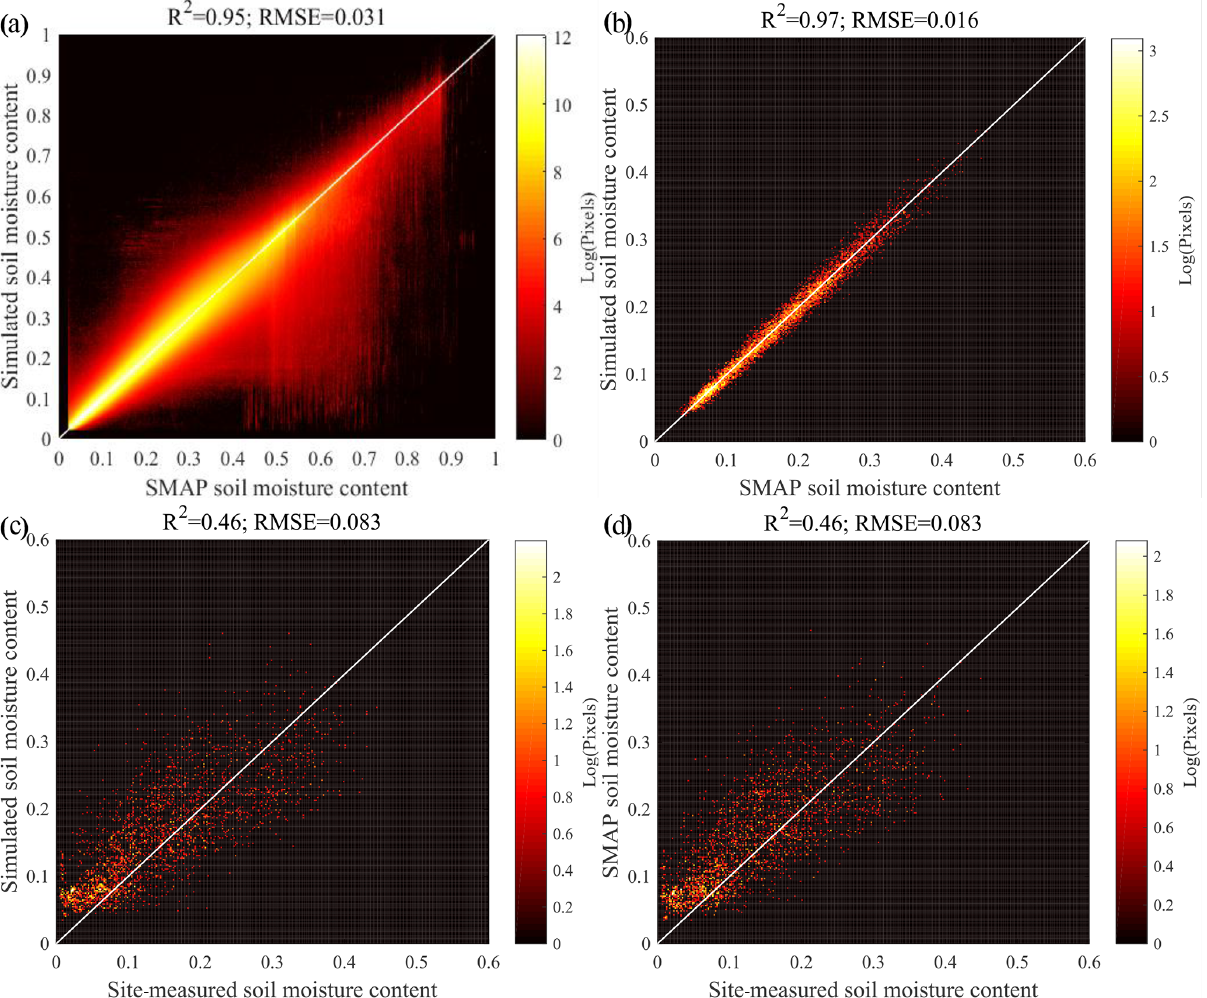
Figure 4. Comparison between the neural-network-simulated surface soil moisture (RSSSM) and SMAP data. The scatterplots are between (a) RSSSM and SMAP values at all pixels, (b) RSSSM and SMAP values at only the pixels with measurements, (c) RSSSM and the site- measured soil moisture from April 2015 to 2018, and (d) SMAP and the site measurements during April 2015–2018. All plots are represented as the point density on a logarithmic scale, while the units for soil moisture content and RMSE values are cubic metres per